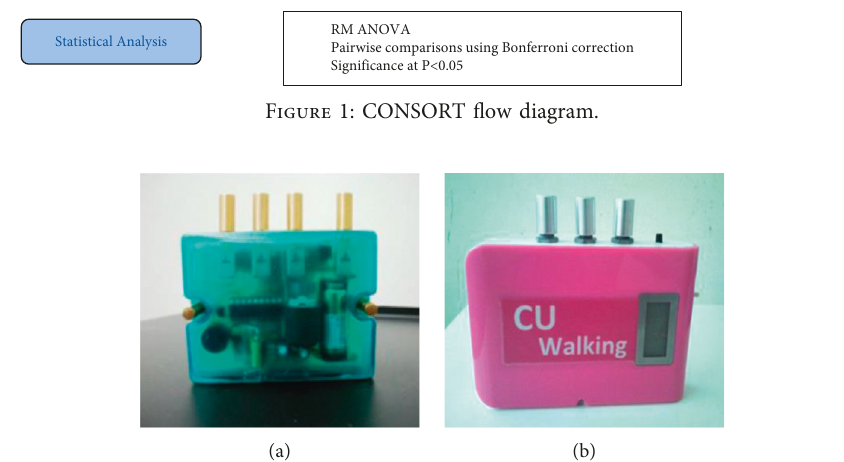
Figure 2: The newly developed cueing device (a) and the beautiful newly developed cueing device (b).